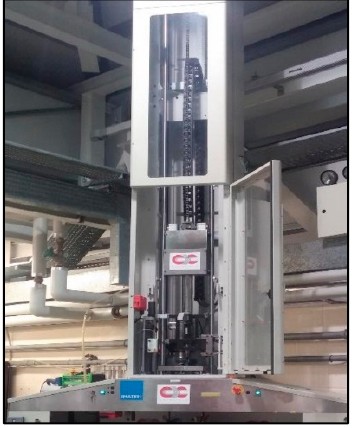
Figure 5. The drop weight tower.